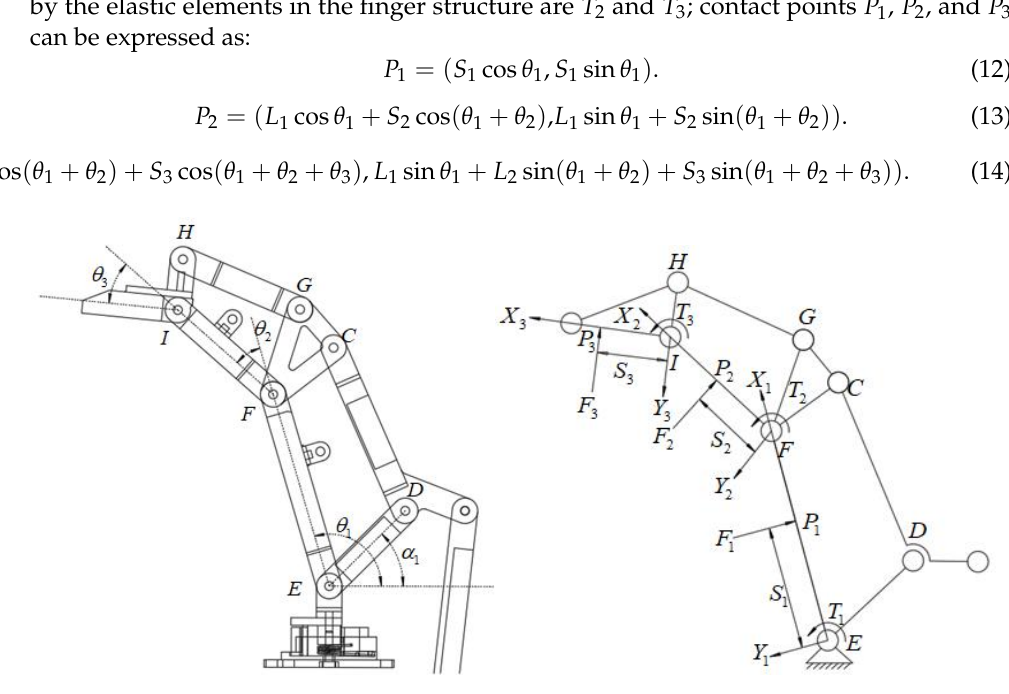
Figure 7. Geometric and static models of underactuated fingers.